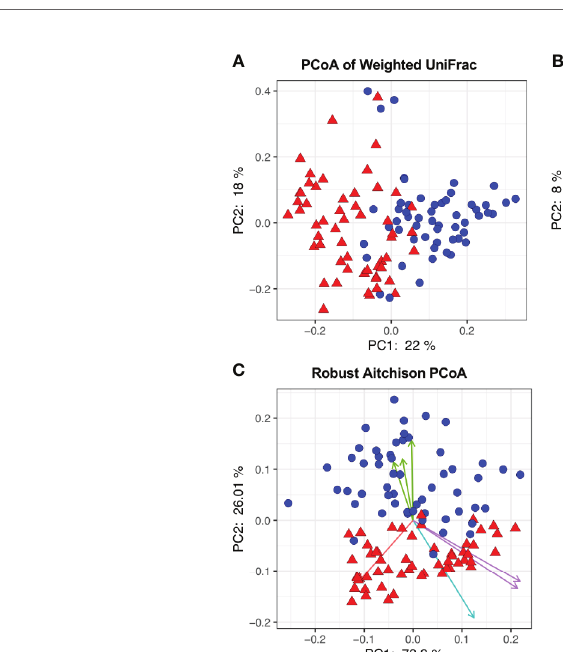
TABLE 2 | Summary of ADONIS permutation-based statistical test on beta diversity metrices. Beta Diversity Distances